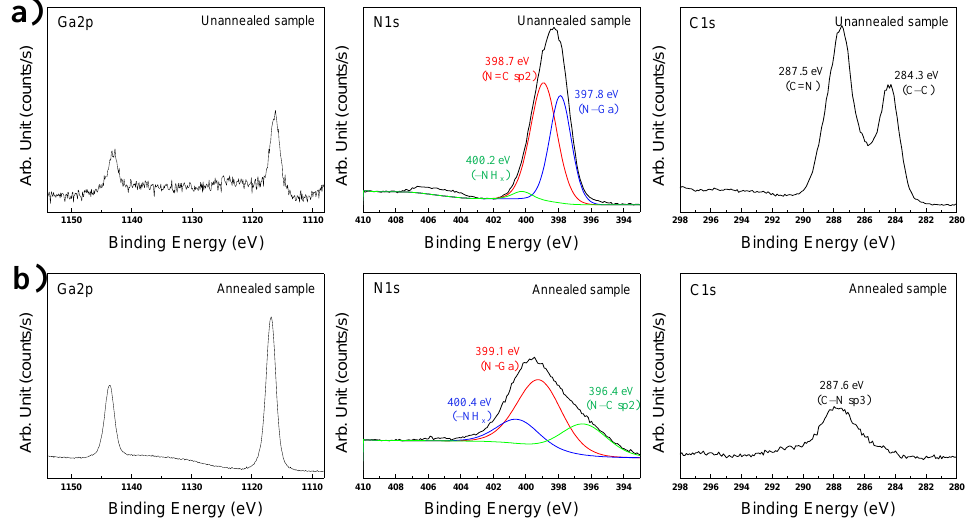
Figure 7. XPS (X-ray photoelectron spectroscopy analysis) of nanopowder synthesized from a Ga(NO 3 ) 3 ∙32H 2 O pellet and C 3 H 6 N 6 powder injection with NH 3 gas by the thermal plasma process in Plasma 3; ( a ) before and ( b ) after annealing.